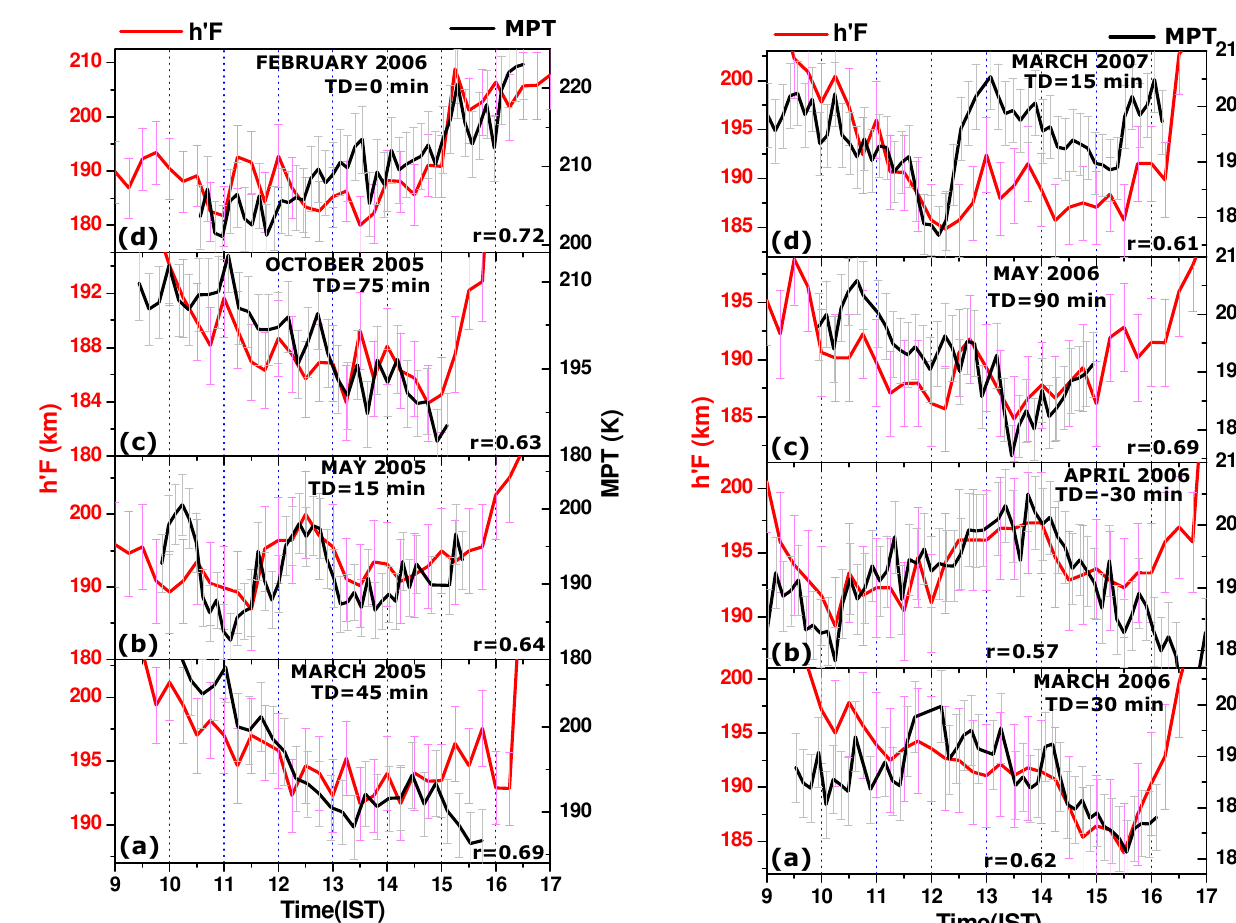
Fig. 2. Same as Fig. 1, but for different months during the years